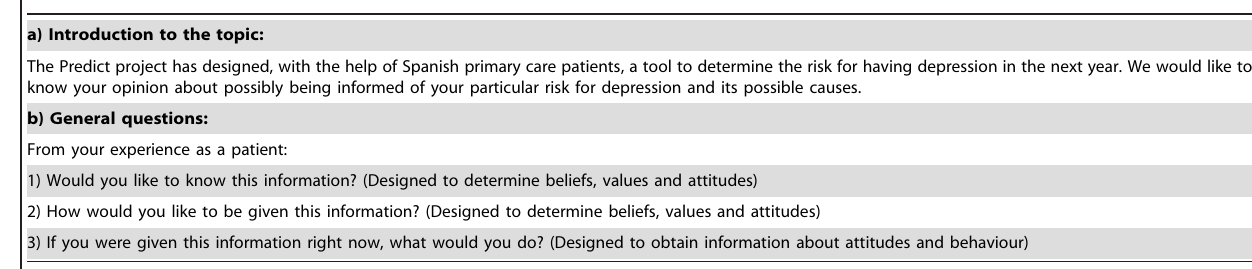
Table 2. Topic guide for the focus